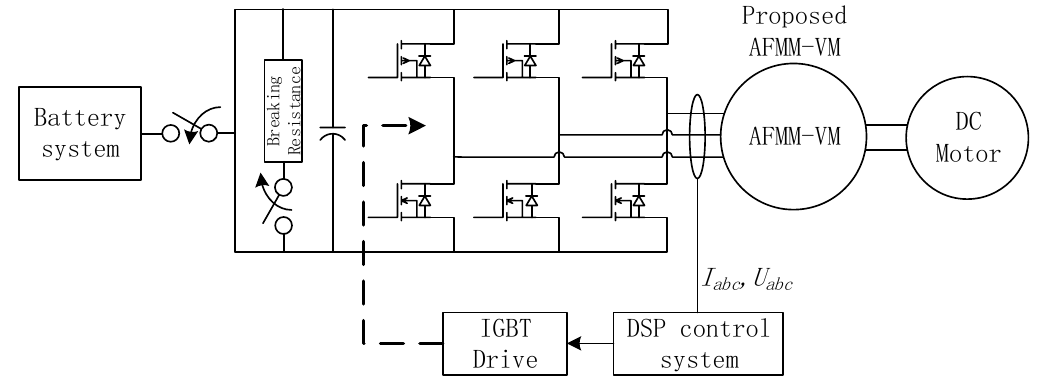
Figure 4. Hardware setup for testing the proposed AFMM-VM.